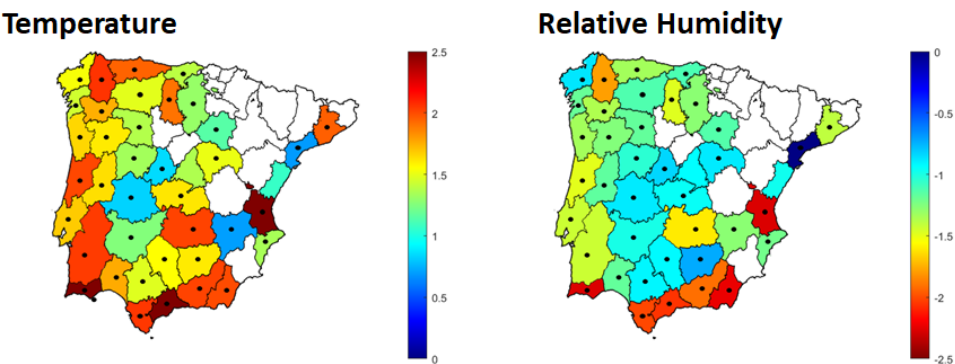
Figure 4 . Standardized anomalies of the temperature and relative humidity values for large fires days under FWT1 (fire weather type 1) conditions in each province The point indicates whether the fire weather type represented is statistically significant at the province level (Kruskal–Wallis non-parametric test with 95% significance). Provinces with very few large fires are represented in white and were disregarded.